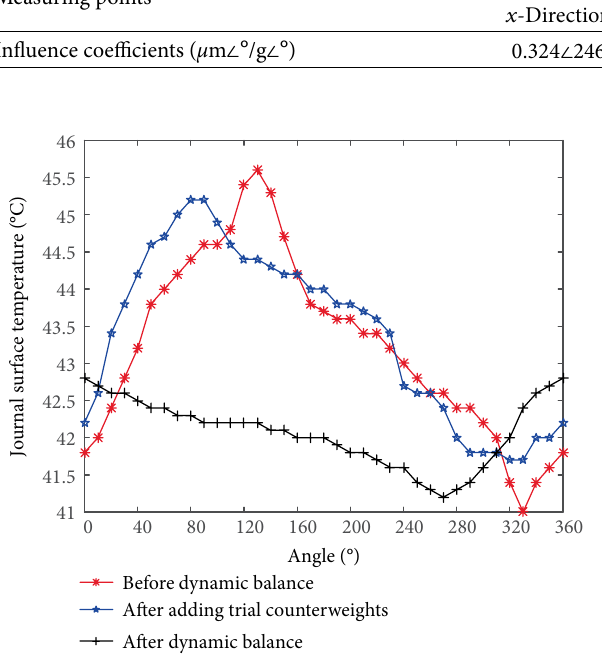
Figure 12: Journal orbits at bearing A under